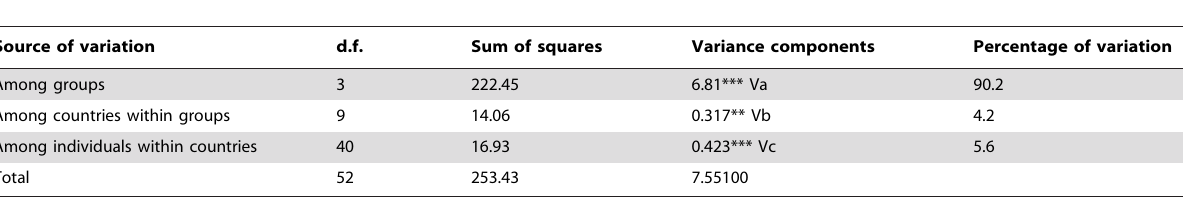
Table 4. Hierarchical analysis of molecular variance for ITS2 in T. dimidiata populations.